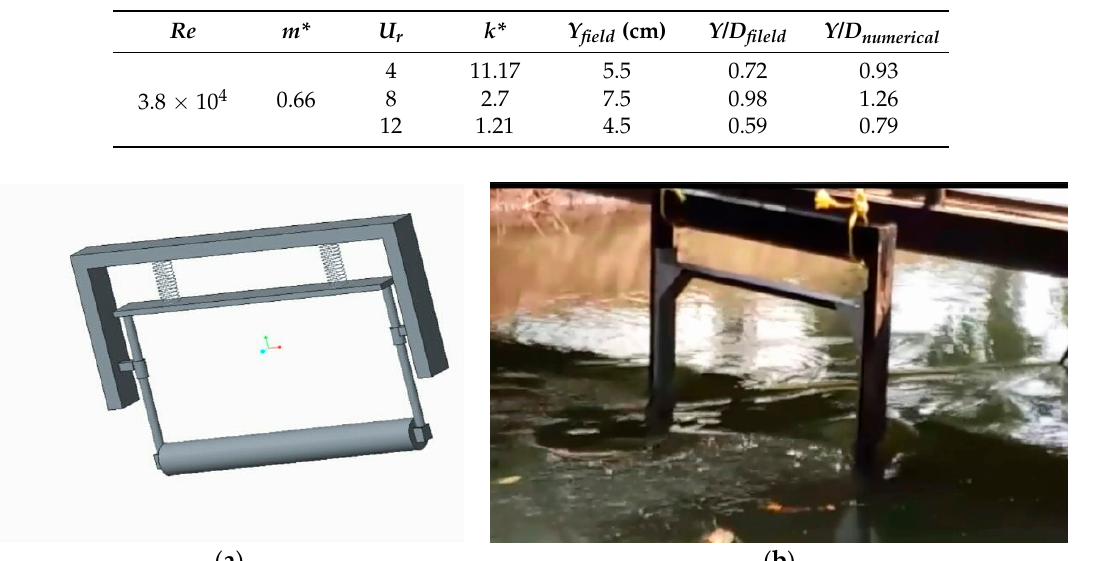
Table 6. Results of field test conducted at Palissery irrigation canal.